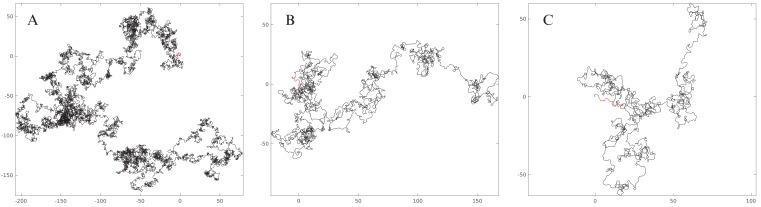
Simulated trajectories with different inter-bout intervals τn.Examples of simulated trajectories with different inter-bout intervals τn=1 displaying different fractal dimensions H. Units : mm. (A) τn=1 s, H=1.5. (B) τn=5 s, H=1.3 (C) τn=10 s, H=1.2. Red segments represent the onset of a sequence.